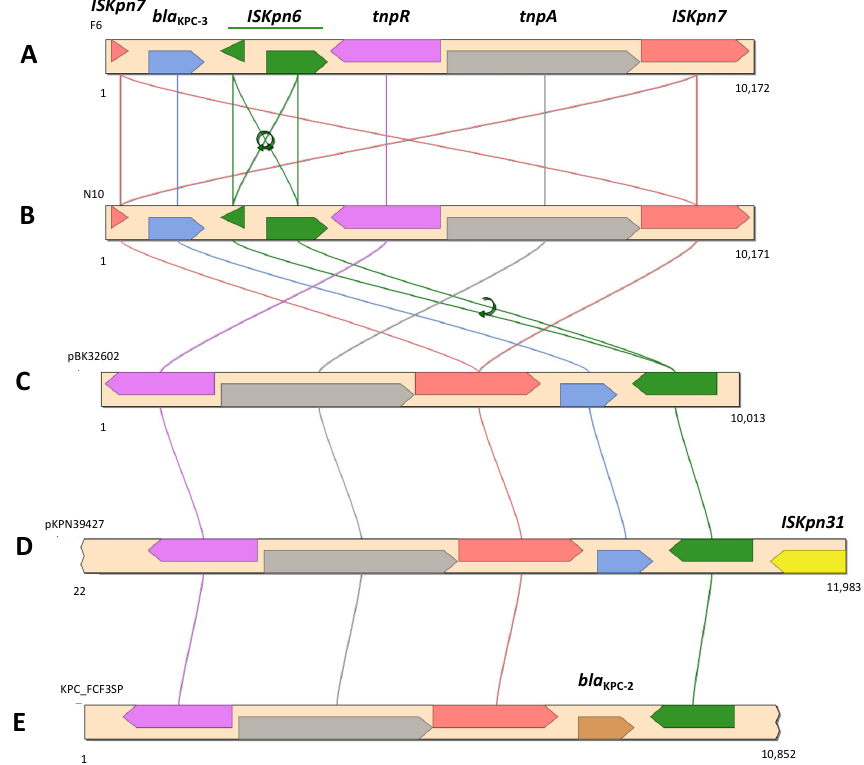
Figure 2. Genetic context of bla KPC-3 in C. freundii F6 ( A ), E. kobei N10 ( B ), E. coli BK32602 ( C ) (KU295134), K. pneumoniae strain 39427 ( D ) (CP054266), and K. pneumoniae FCF3SP ( E ) (CP004367). The Tn 4401 b isoform was confirmed, as no deletions were observed in the 386 bp re ‐ gion [71]. However, both ISKpn6 and ISKpn7 were fragmented (Figure 2). The bla KPC ‐ 3 ‐ har ‐ boring contig (10,172 bp) revealed the same nucleotide sequence (100% identity; query cov ‐ erage of 98%) with the corresponding region of an IncN plasmid described in a clinical E. coli strain (KU295134), and 99.7% of nucleotide sequence similarity (query coverage of 97%) with one other IncN plasmid described in several K. pneumoniae clinical strains [72], and also with a IncFIB/FII plasmid identified in a K. pneumoniae clinical strain (CP054266) [73]. 3.5.2. R. ornithinolytica N9 The R. ornithinolytica N9 draft genome was 6,252,962 bp in size and organized in 420 contigs, with 55.2% in terms of G + C content, an N50 of 109,201, and 6014 predicted coding sequences (Table S3). A total of 130 virulence factors were predicted for R. ornithinolytica N9 across 12 virulence categories, with adherence ( n = 44), iron uptake ( n = 34), and secre ‐ tion systems ( n = 20) being the most represented (Figure S5).